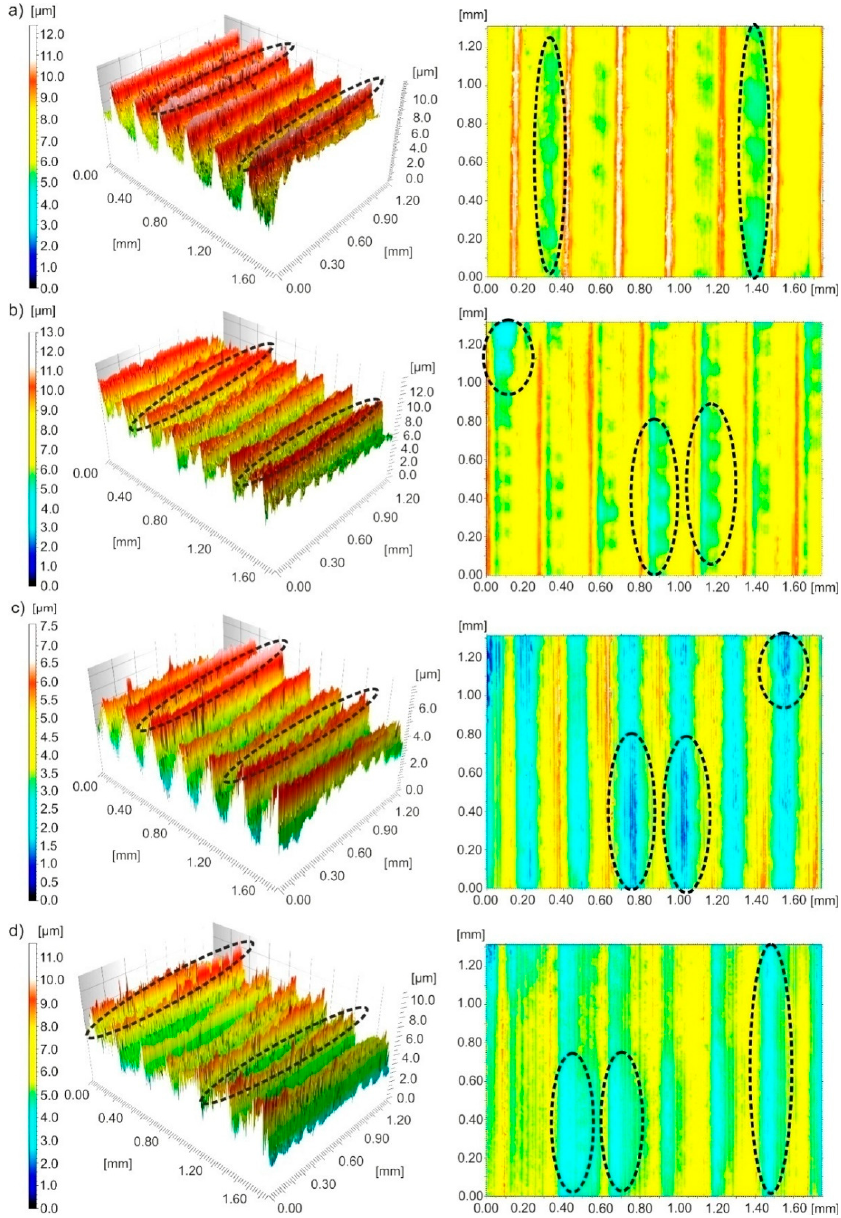
Figure 11. Three-dimensional images and contour maps of the surface machined with a speed of v c ~456 m/min and feed of f ~0.27 mm/rev obtained under processing conditions: ( a ) dry; ( b ) wet; ( c ) MQL; ( d ) MQL+EP.